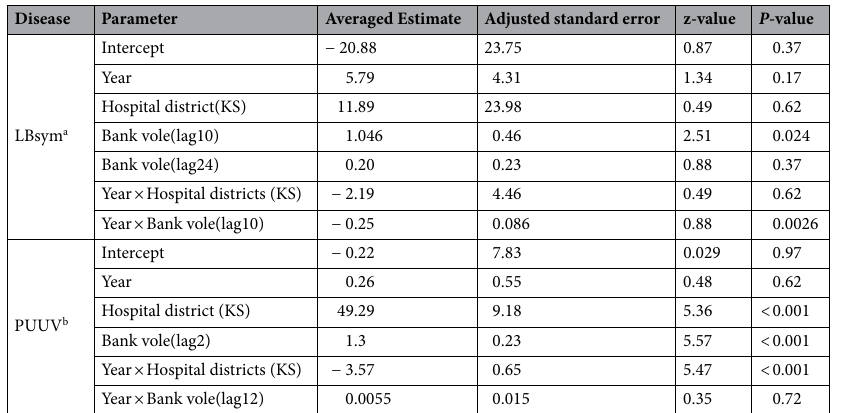
Table 2. Model-averaged fixed effects (including models with ΔAICc < 2) of linear mixed-effects models explaining LB symptoms incidence from 2011 to 2019 and PUUV infection incidence from 1995 to 2019 in Central Finland (KS) and Northern Savo (PS) hospital districts. The models were fitted with the maximum likelihood method. a Month was used as a random effect. Temporal autocorrelation of residuals was modelled with the AR(2) function. b Month was used as a random effect. Temporal autocorrelation of residuals was modelled with the ARMA(1,1)